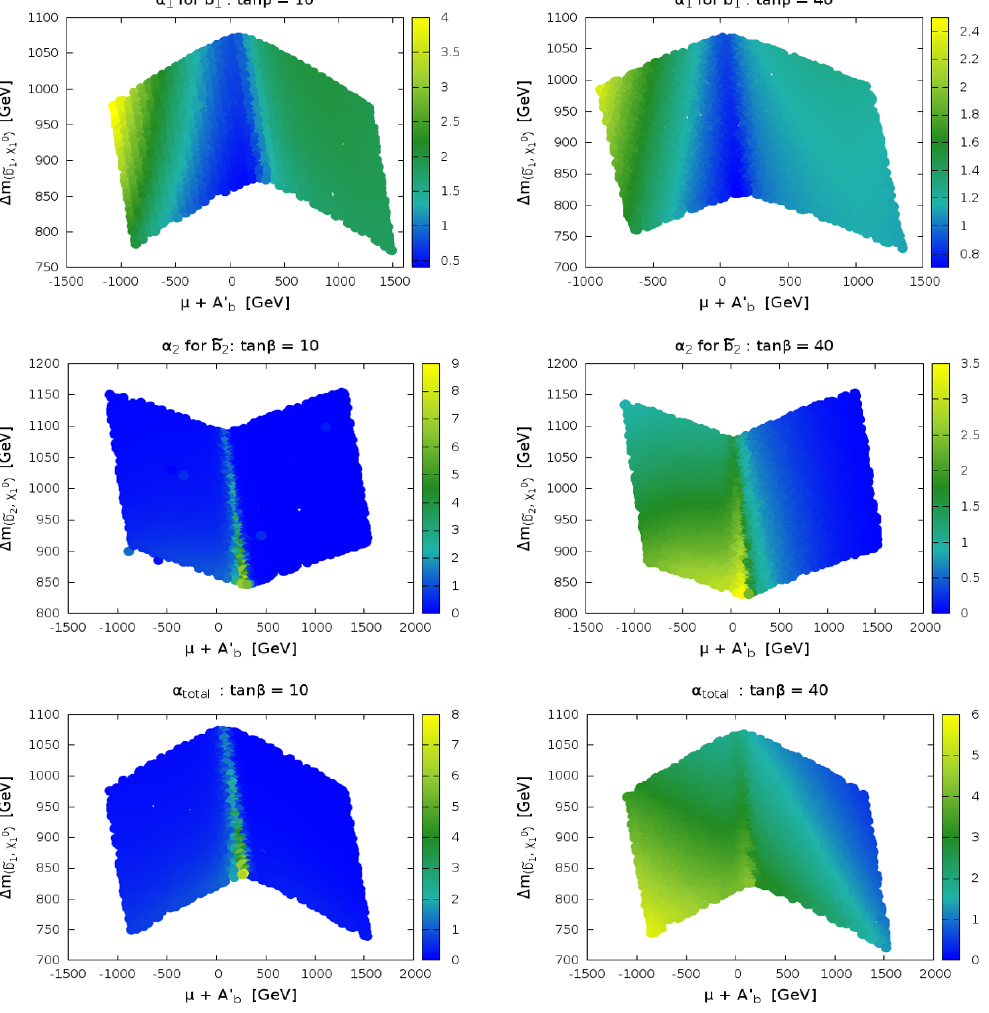
Figure 15 . Relative rates ( (cid:11) ) between the NHSSM and the MSSM scenarios in the (cid:12)nal state 2 b + =E in the plane of (cid:22) + A 0 and (cid:1) m (~ obtained from ~ b 1 pair-production (top row), ~ b 2 pair- T b b i ;(cid:31) 0 1 ) production (middle row) and sum of ~ b 1 and ~ b 2 pair-production (bottom row) for tan (cid:12) = 10 (left panel) and 40 (right panel). ‘ (cid:22) ’ is varied over the range 100 GeV (cid:22) 350 GeV while the other (cid:20) (cid:20) (cid:12)xed parameters are: M 1 = 500 GeV, M 2 = 1 : 1 TeV, A t = 2 TeV, A b = 0, m ~ = m ~ =1.2 TeV b L b R and (cid:22) 0 =